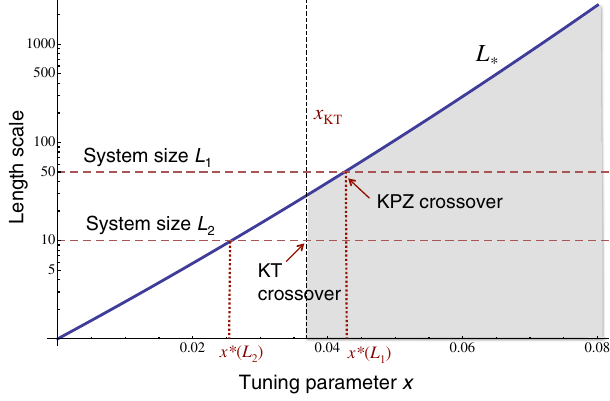
FIG. 2. Dependence of the emergent KPZ length scale L (cid:2) (in units of the microscopic healing length) on the tuning parameter − 1 . This curve was obtained by inserting the ex- x ¼ γ = γ p l pression [Eq. (9)] for the bare coupling g 0 into Eq. (8) for L (cid:2) . While L (cid:2) is exponentially large when x > ¯ u ¯ γ 2 = 2 π , it goes to a microscopic value ξ 0 at the mean-field transition x ¼ 0 þ . The shaded region marks the scales at which a system would exhibit algebraic correlations. Upon decreasing the tuning parameter x , a finite system will lose its algebraic order in one of two ways: (1) when L (cid:2) falls below the system size, as in the case of system L 1 shown, or (2) when a KT transitions occurs before L (cid:2) falls below the system size, as in the case of system L 2 . Here, we have used ¯ γ ¼ 0 . 8 and ¯ u ¼ 0 . 14